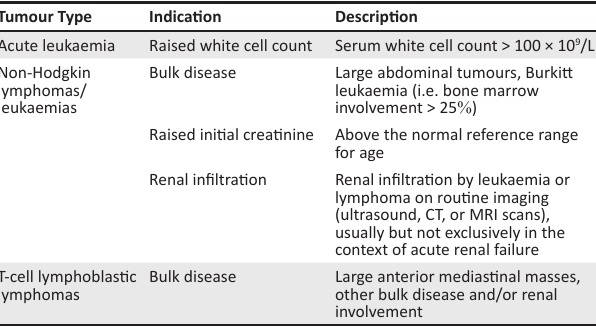
TABLE 1: Indications for administration of rasburicase at Red Cross War Memorial Children’s Hospital. Tumour Type Indication Description Acute leukaemia Raised white cell count Serum white cell count > 100 × 10 9 /L Non-Hodgkin lymphomas/